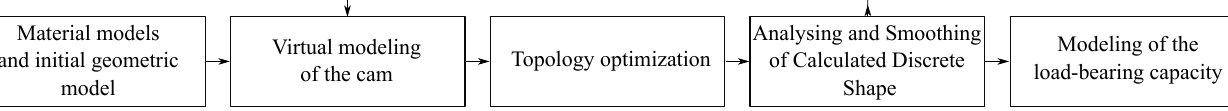
Figure 4. A diagram showing the research workflow of process of obtaining the optimal cam shape.